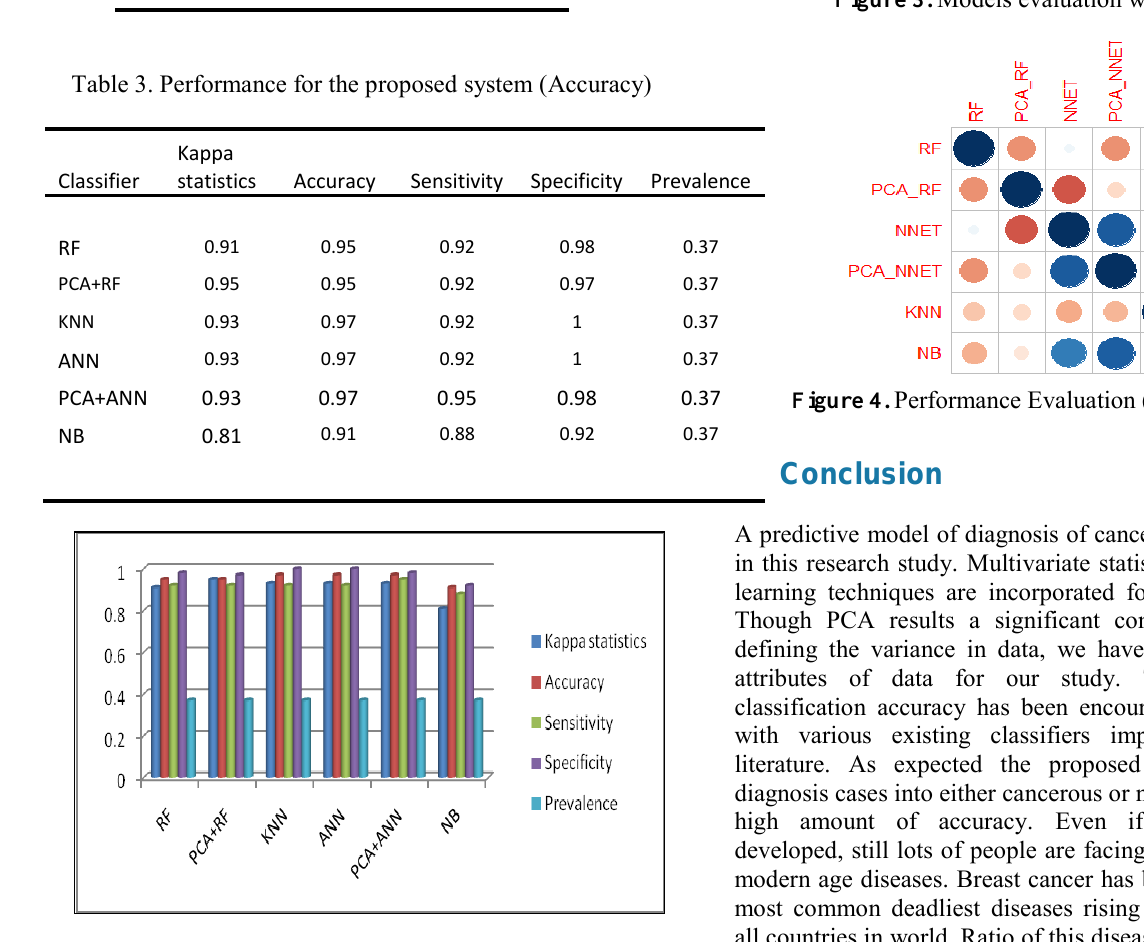
Figure 2. Performance of different classifiers Table 3 and Figure 2 help to visualize the accuracy of the proposed method. Figure 4 shows graphical representation of the performance of the proposed method mention in